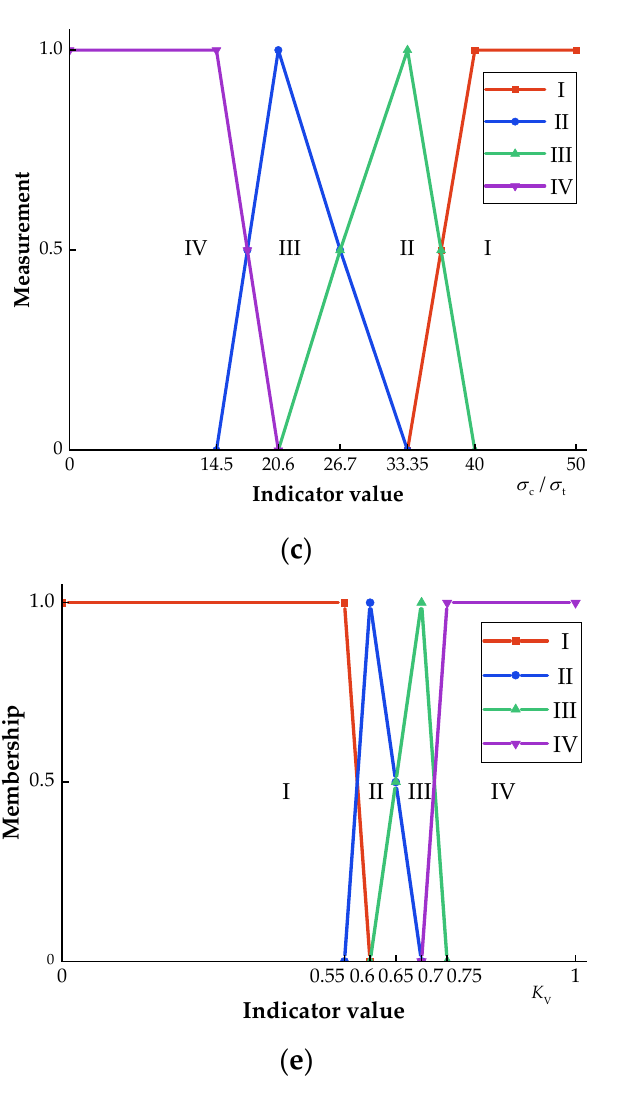
Figure 3. Single-indicator measurement functions for rockbursts. ( a ) Measurement function of rock uniaxial compressive strength. ( b ) Measurement function of rock shear to compressive strength ratio. ( c ) Measurement function of rock compressive strength–tensile strength ratio. ( d ) Measurement function of rock elastic deformation coefficient. ( e ) Measurement function of rock integrity coefficient. Table 3. Indicators and classes of actual rockburst